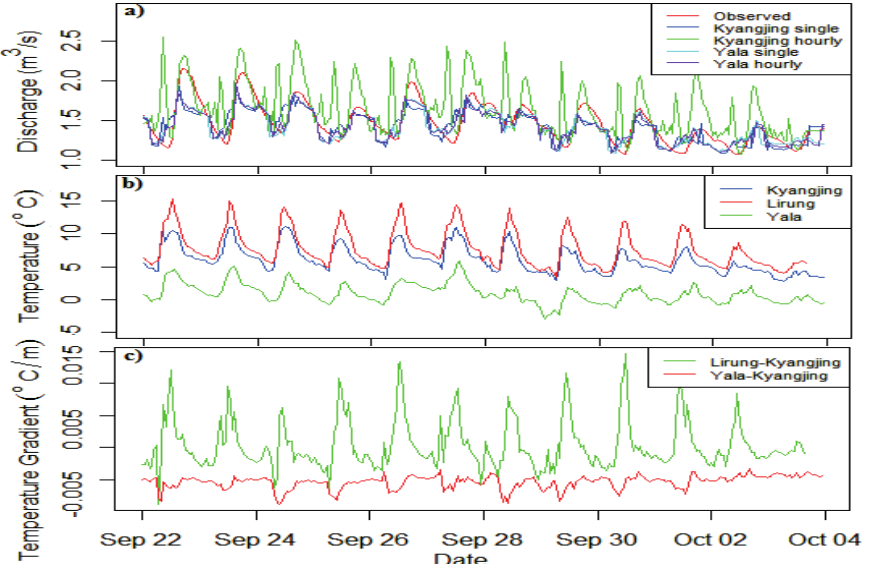
Fig. 3 Uncertainty analysis: (a) estimated discharge using single and hourly temperature gradient from different stations; (b) air temperature at Lirung, Kyangjing and Yala stations; and (c) hourly temperature